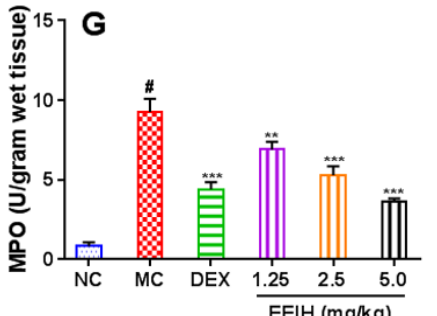
Figure 4. Effects of EEIH on histopathological changes ( A – F ) and MPO activity ( G ) of liver tissue in LPS-induced ALI mice. The liver sections were stained using H&E. The light photomicrographs shown were representative of liver sections from five mice per group. The black arrows showed inflammatory cells in liver tissues. ( A ) Normal control (NC), ( B ) model control (MC), ( C ) dexamethasone (DEX, positive control), ( D ) EEIH (1.25 mg/kg), ( E ) EEIH (2.5 mg/kg), and ( F ) EEIH (5.0 mg/kg). The values are presented as the means ± SD ( n = 5). P values were determined by ANOVA and a Tukey post-hoc test. Significant differences compared to the NC group are designated as # p < 0.001; those compared to MC group as ** p < 0.01 and *** p < 0.001.